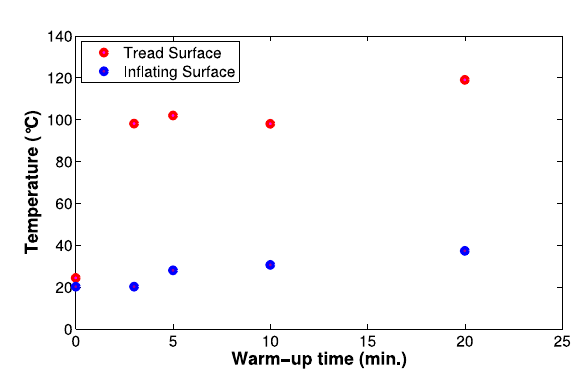
Figure 14. Increase in the temperature of tire tread and inflating tire